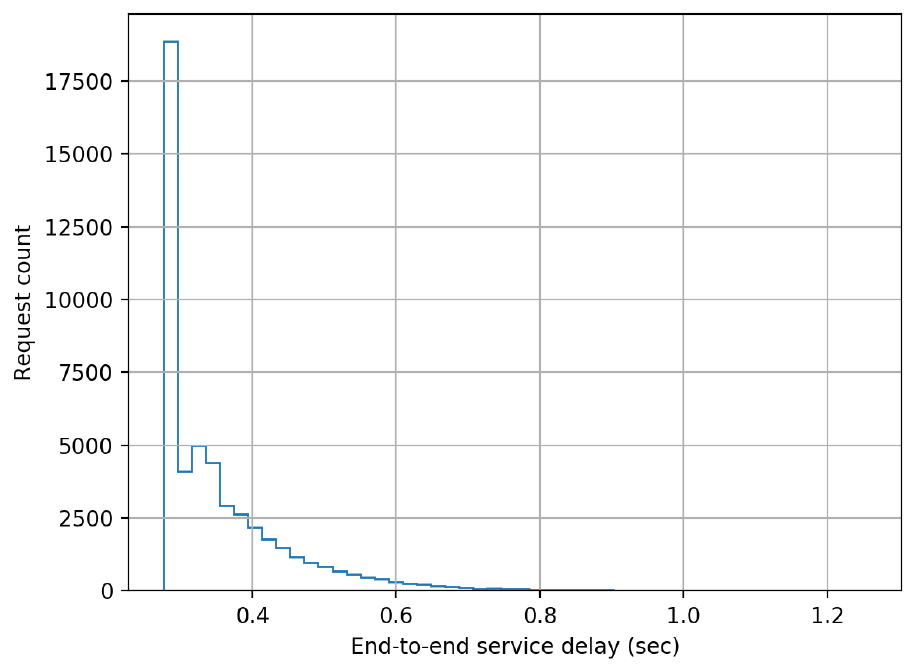
Figure 3. Distribution of end-to-end service delay at a mean request rate of 10 requests-per-second